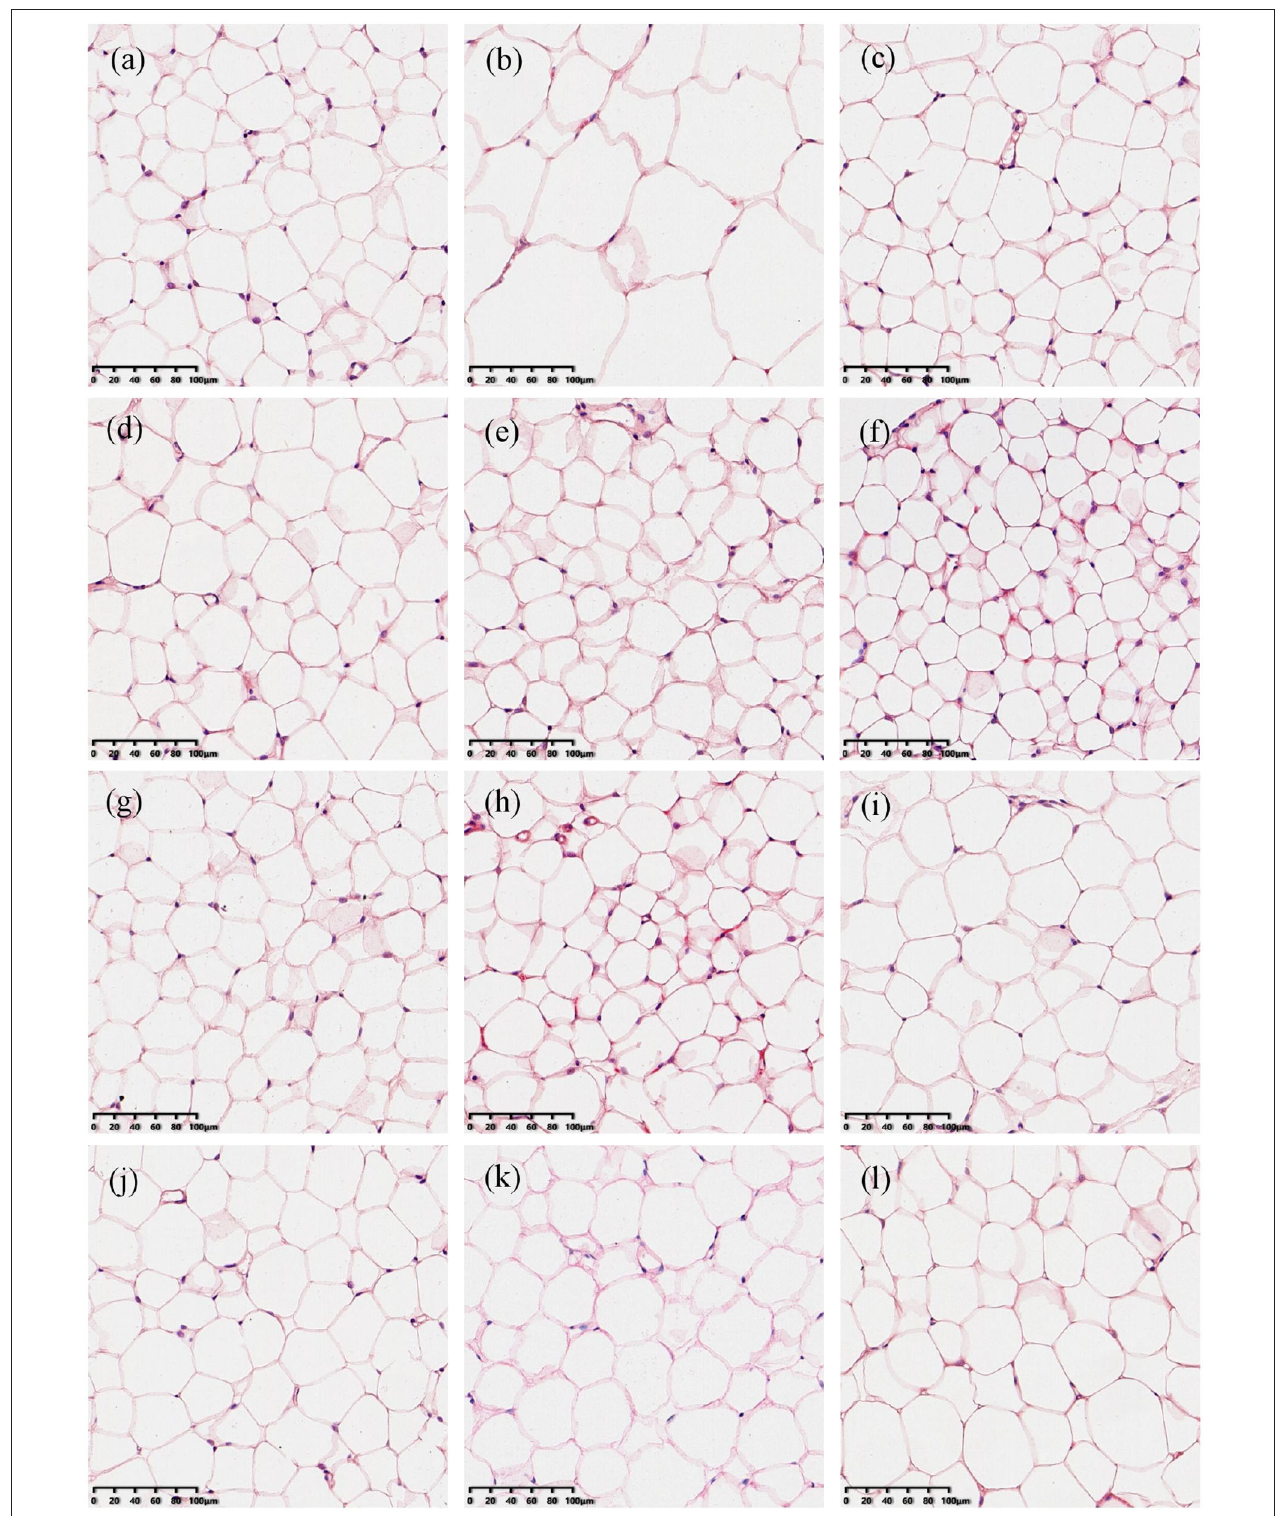
FIGURE 3 | Histopathological changes of epididymal adipose tissues (200X magnification). (a) The control group; (b) the model group; (c) the GT1 group; (d) the GT2 group; (e) the GT3 group; (f) the GT4 group; (g) the GT5 group; (h) the GT6 group; (i) the GT7 group; (j) the GT8 group; (k) the GT9 group; and (l) the GT10 group. ND, normal diet; HFD, high-fat diet; GT1, Dianqing Tea; GT2, Jieyang Chaoqing Tea; GT3, Fenggang Zinc-Selenium-Enriched Tea; GT4, Liping Xiang Tea; GT5, Taiping Houkui Tea; GT6, Xihu Longjing Tea; GT7, Chaoqing Green Tea; GT8, Selenium-Enriched Chaoqing Green Tea; GT9, Selenium-Enriched Matcha; GT10, Seven Star